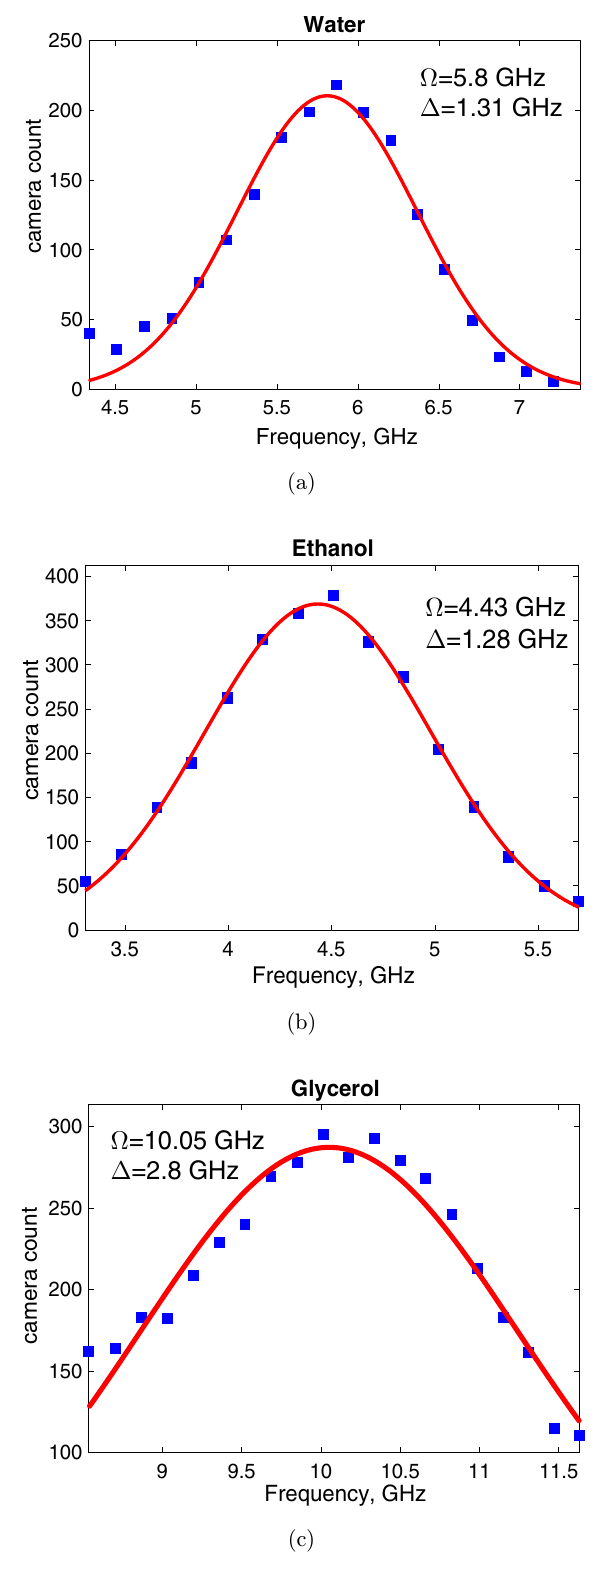
Fig. 4. Brillouin spectral peaks recorded using the dual-¯ber setup [Fig. 2(c)] for water, ethanol and glycerol (markers) ¯tted with Lorentzian lineshapes (solid